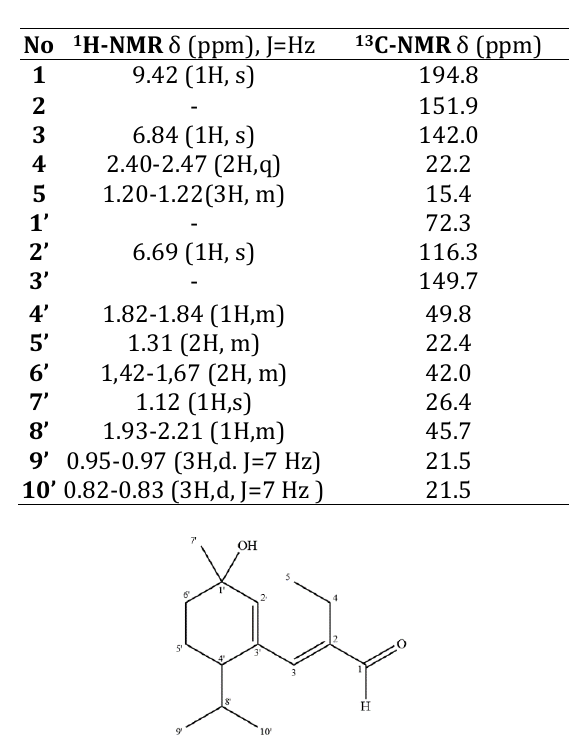
Figure 3. Structure of compound 1 Table II. IC 50 values of the isolated